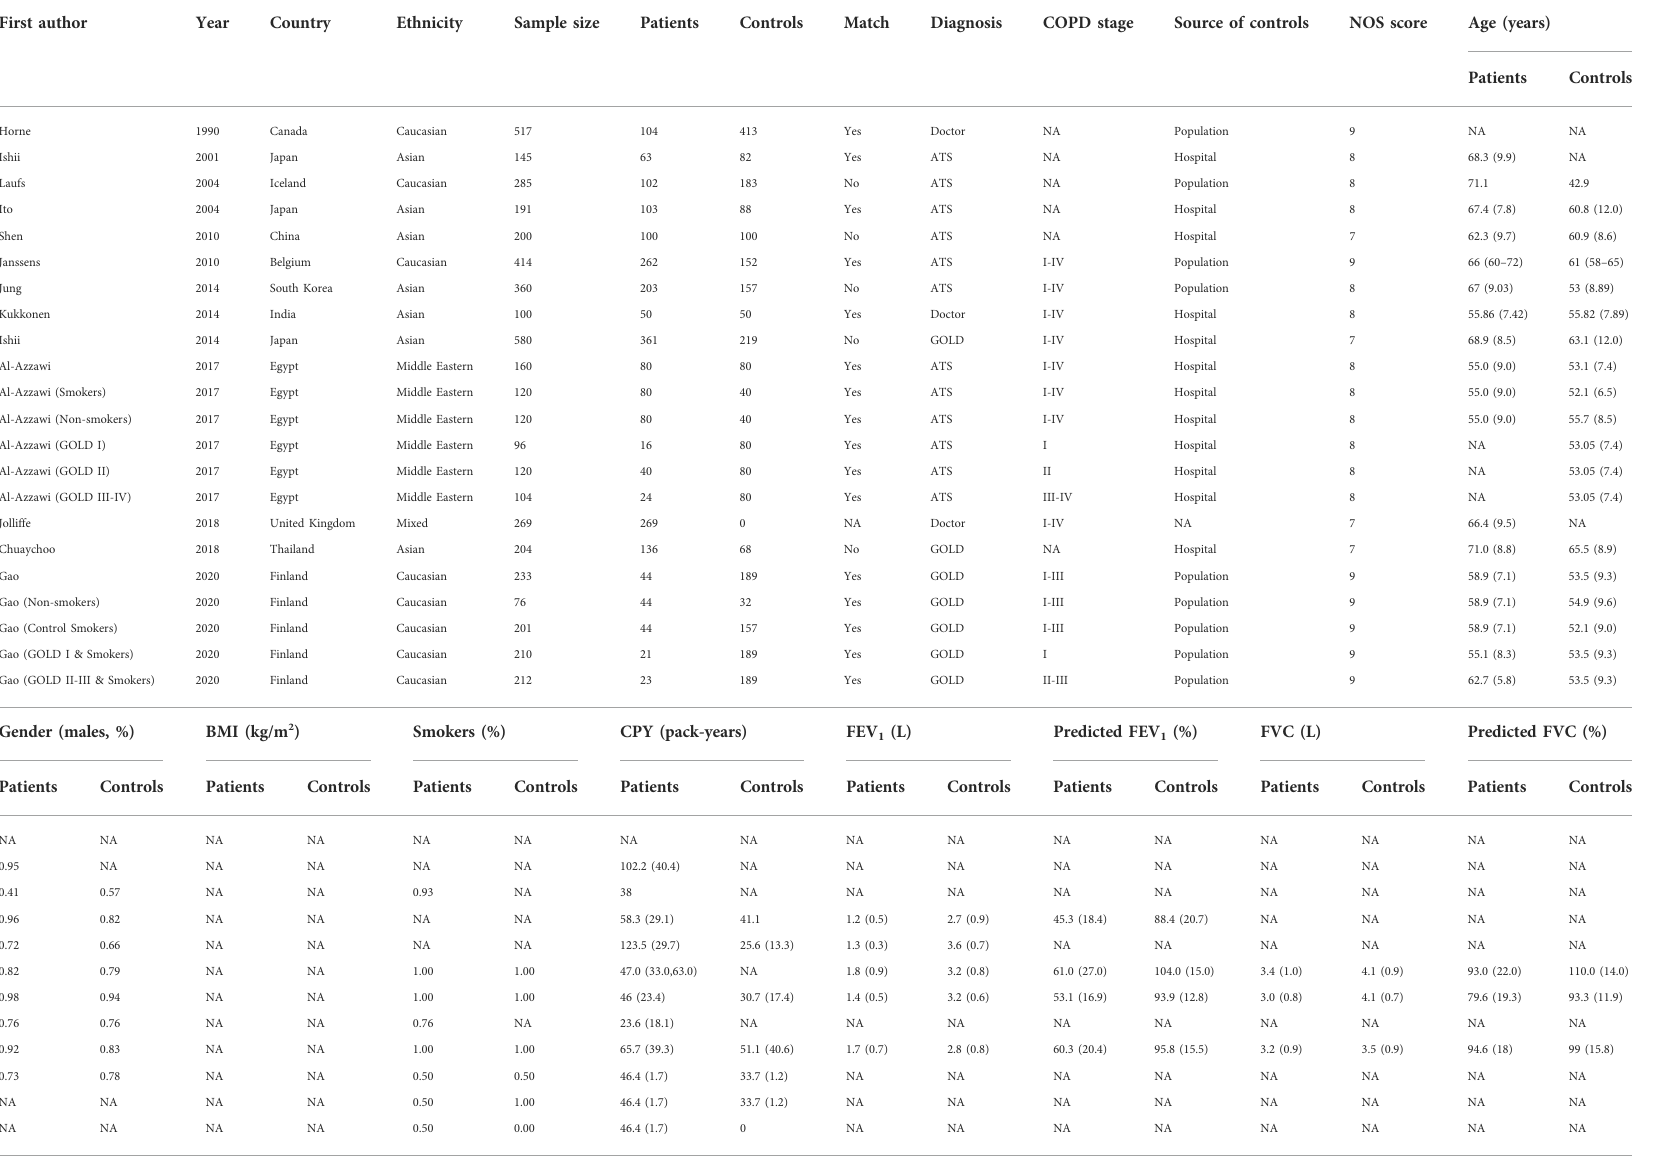
TABLE 1 Baseline characteristics of all involved studies in this